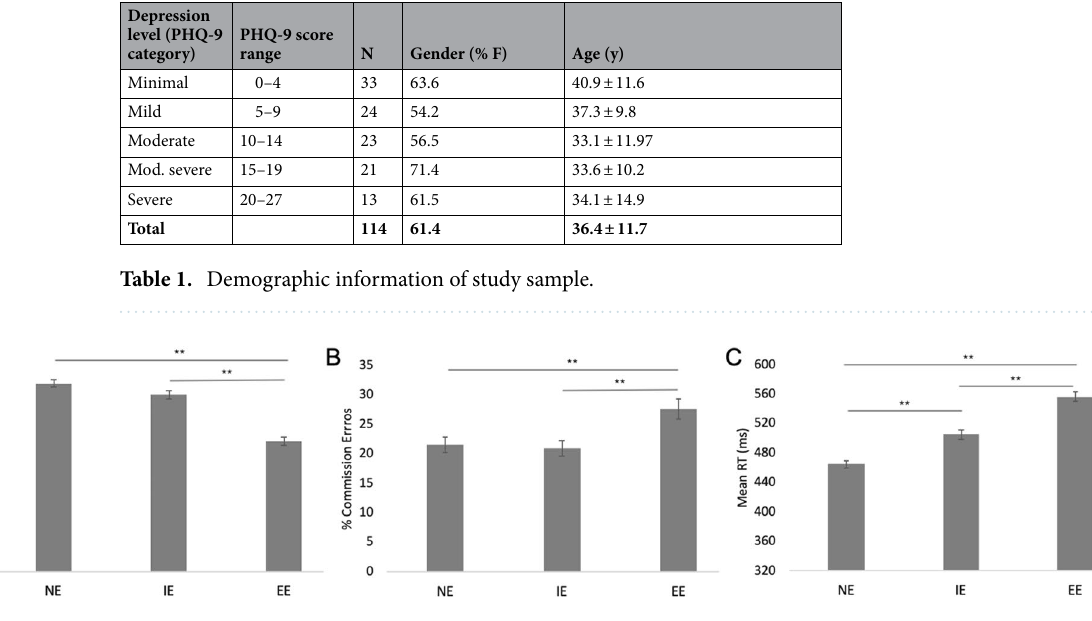
Figure 1. Comparison between the three GNG task variations: no-emotion (NE), implicit emotion (IE) and explicit emotion (EE). ( A ) d’; ( B ) Percentage of commission errors for No-Go trials; ( C ) Mean reaction time (RT) in ms; Averages and standard errors of mean (SEMs) are